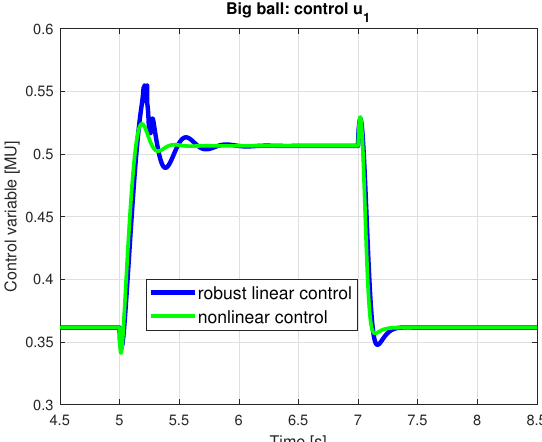
Figure 19. Big ball—output position y = x 1 : comparison of simulation results for nonlinear and robust linear pole-placement controllers.